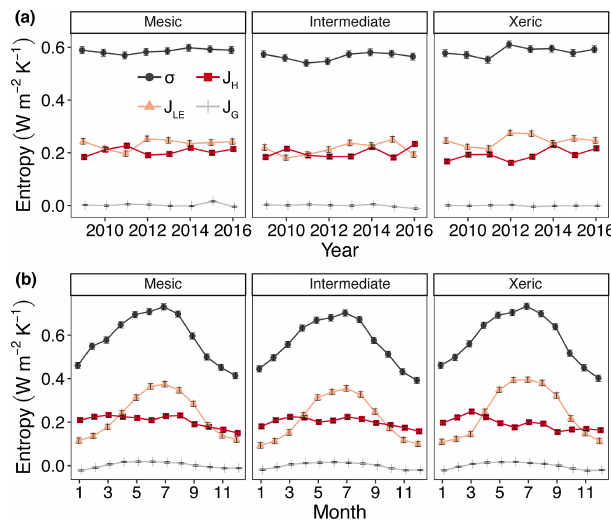
Figure 5. Least squares mean predicted values from mixed mod- els of annual (a) and monthly (b) average entropy production ( σ ) and entropy fluxes of latent energy ( J LE ), sensible heat ( J H ) and ground heat ( J G ) at the mesic, intermediate and xeric sites. Error bars represent